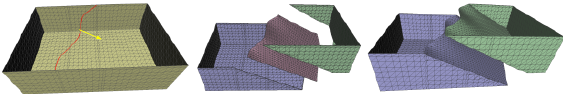
Figure 1. Fundamental body split by the geological interface Step 3, the fundamental body was split into two fundamental bodies by the interface. During the split process, an interface boundary was acquired and the interface was reconstructed by vertical scanning line method (Figure 1) to make the interface pass through the boundaries.